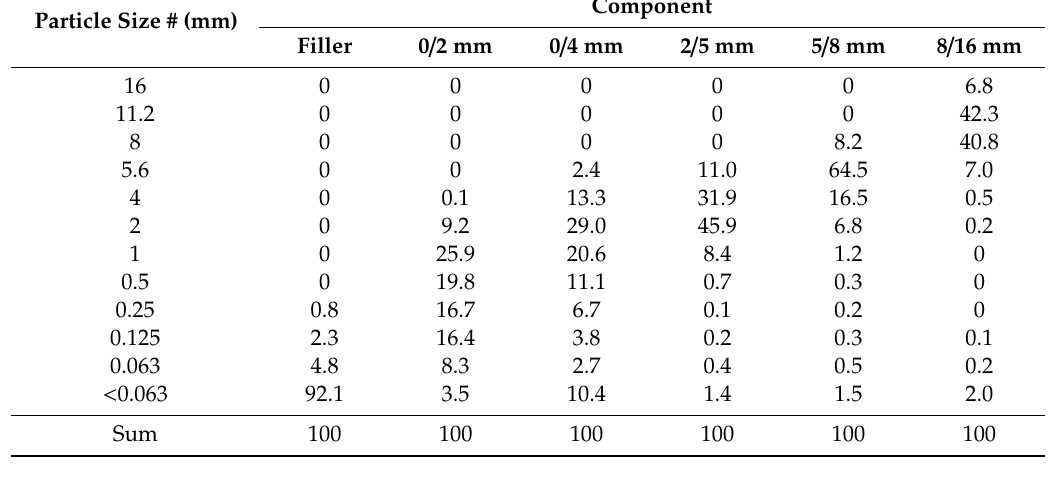
Table 3. Results of sieve analysis of mineral aggregates used in AC 16 asphalt mixes.